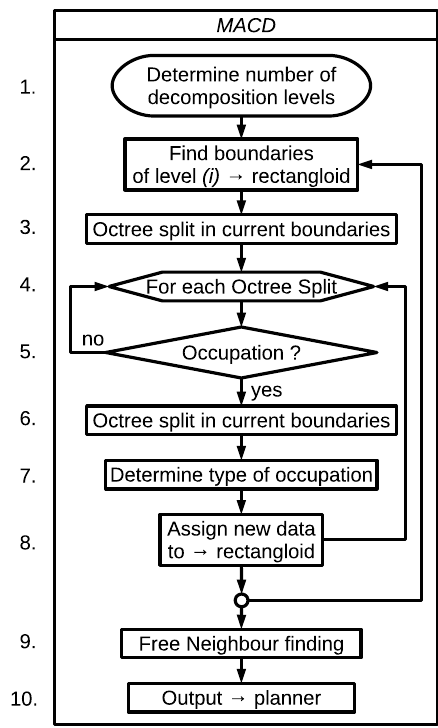
Figure 2. Flowchart of modified adaptive cell decomposition ( MACD